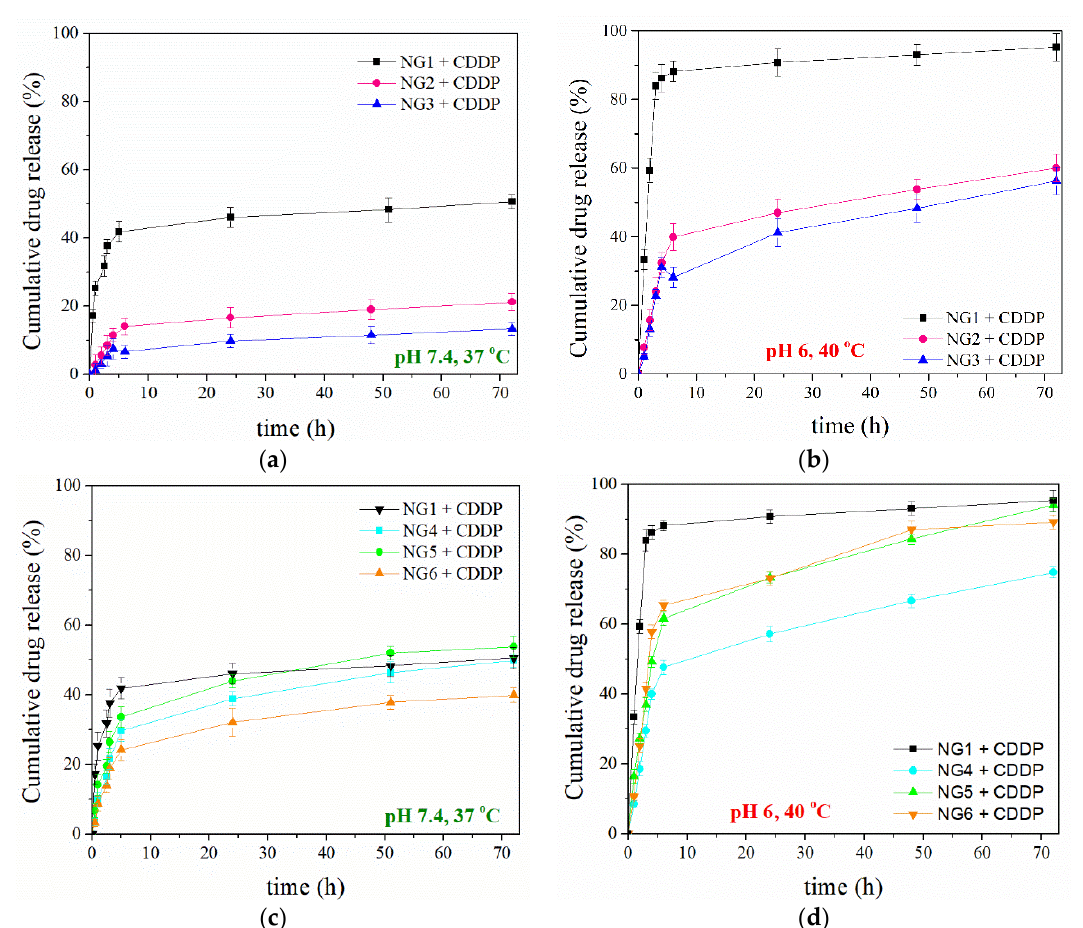
Figure 3. Cumulative CDDP release from nanogels at different conditions. From PNVCL:VP:PEGMA nanogels: ( a ) at pH 7.4, T = 37 °C; ( b ) at pH 6, T = 40 °C. From PNVCL:GAL:PEGMA nanogels: ( c ) at pH 7.4, T = 37 °C; ( d ) at pH 6, T = 40 °C.